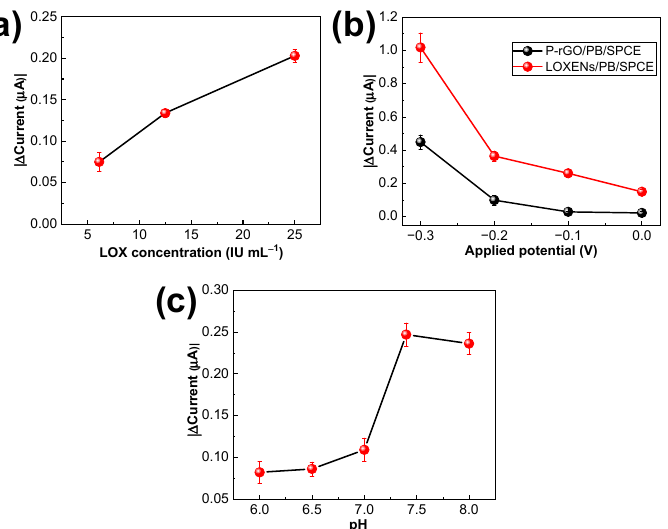
Figure 5. ( a ) Current changes in response to 100 µ M lactate for LOXENs/PB/SPCE fabricated using various loadings of LOX. ( b ) Current changes under various applied potentials for P-rGO/PB/SPCE and LOXENs/PB/SPCE in 50 mM PBS (pH 7.4). ( c ) Current changes to 100 µM lactate solution prepared in PBS (50 mM, various pH) for LOXENs/PB/SPCE.